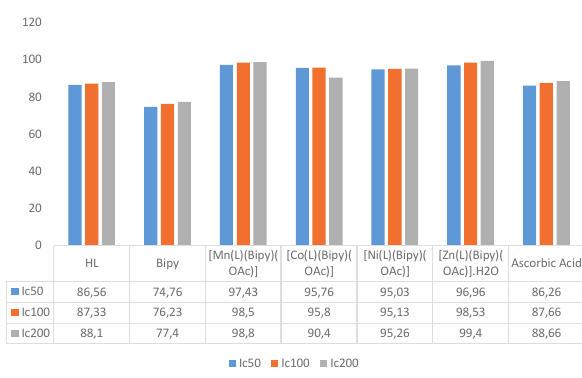
Figure 8: Histogram presentation of DPPH radical scavenging results.